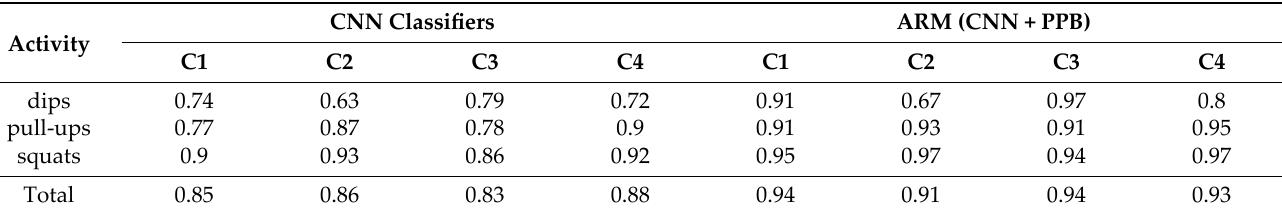
Table 8. The accuracies for single and all activities.